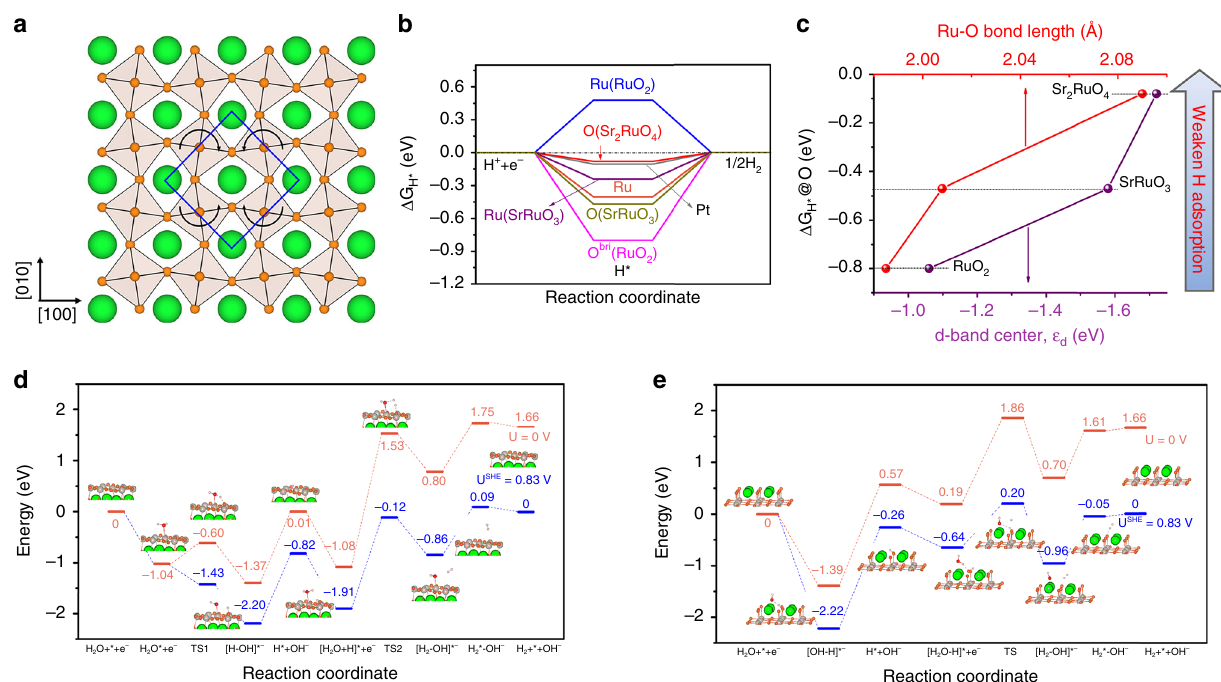
Fig. 3 DFT calculations. a Top view of the SrO-terminated Sr 2 RuO 4 (001) surface. The RuO 6 octahedra are alternately tilted with respect to the c- axis, and rotated in the ab plane as indicated by the curved arrows. b Free-energy diagram for hydrogen adsorption at the metal and oxygen sites on Sr 2 RuO 4 , SrRuO 3 , RuO 2 , Ru, and Pt. c Relationship between Δ G H* @O and d-band center as well as Ru − O bond length. Energy diagram and the simpli fi ed surface structures of the various reaction species along the Volmer − Heyrovsky pathway for HER in alkaline media on the d RuO 2 -terminated surface of SrRuO 3 and e SrO-terminated surface of Sr 2 RuO 4 at electrode potential U = 0 V and U SHE = 0.83 V, respectively. TS transition state. The gray, green, orange/red, and light gray spheres represent Ru, Sr, O, and H atoms,